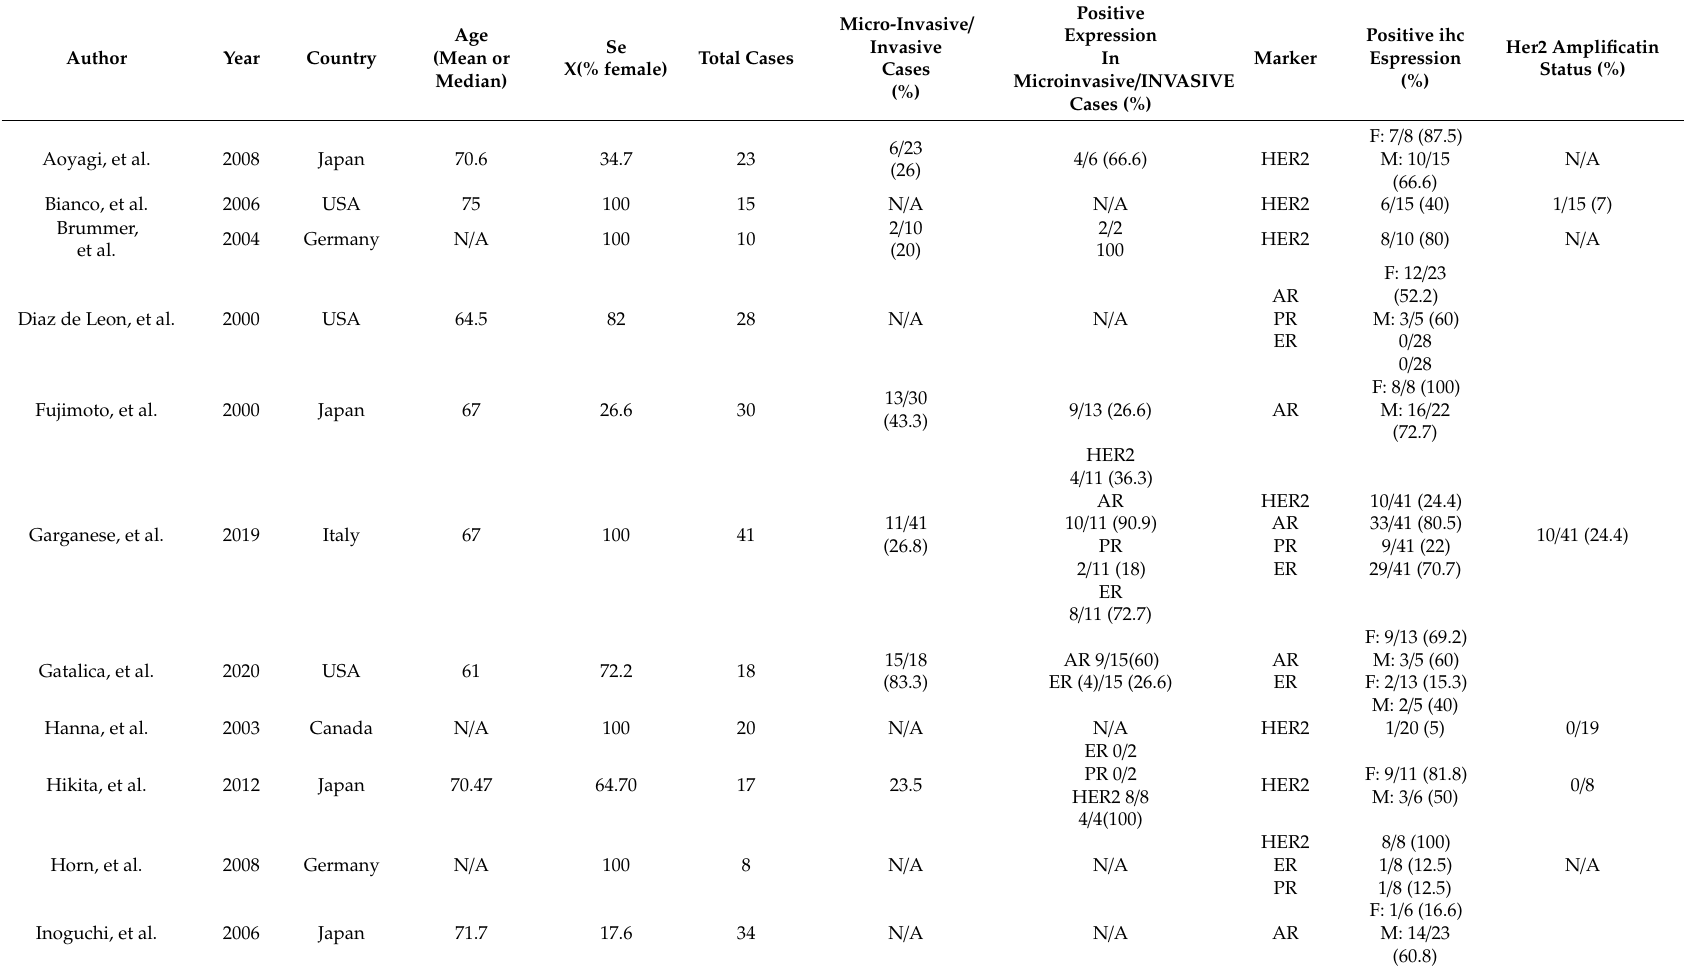
Table 1. Characteristics of Included Studies in the